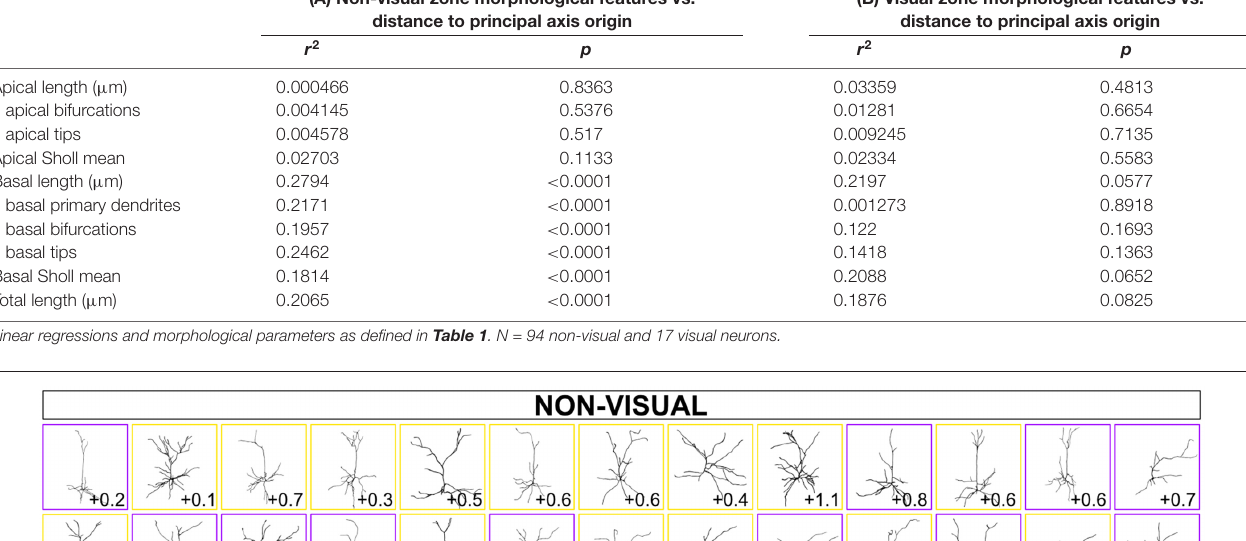
TABLE 3 | Dividing the cortex into two “zones” reveals stronger relationships between neuronal position on the cortical sheet and basal dendritic morphological properties in the non-visual zone. (A) Non-visual zone morphological features vs. (B) Visual zone morphological features vs. distance to principal axis origin